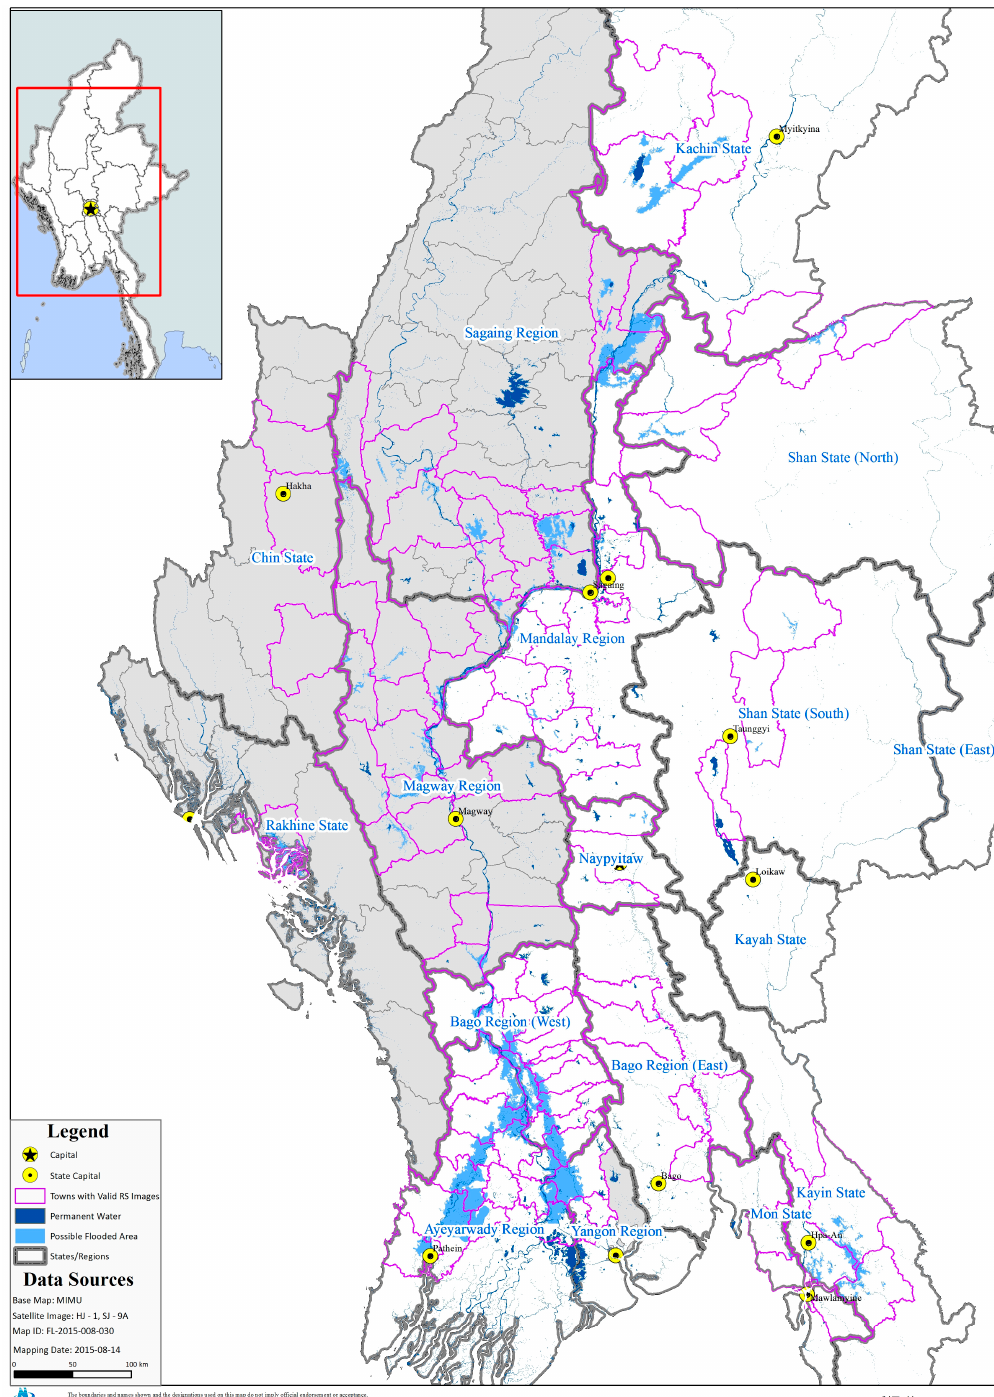
Figure 6. Flood Extents of the Myanmar Flood (as of 14 August).